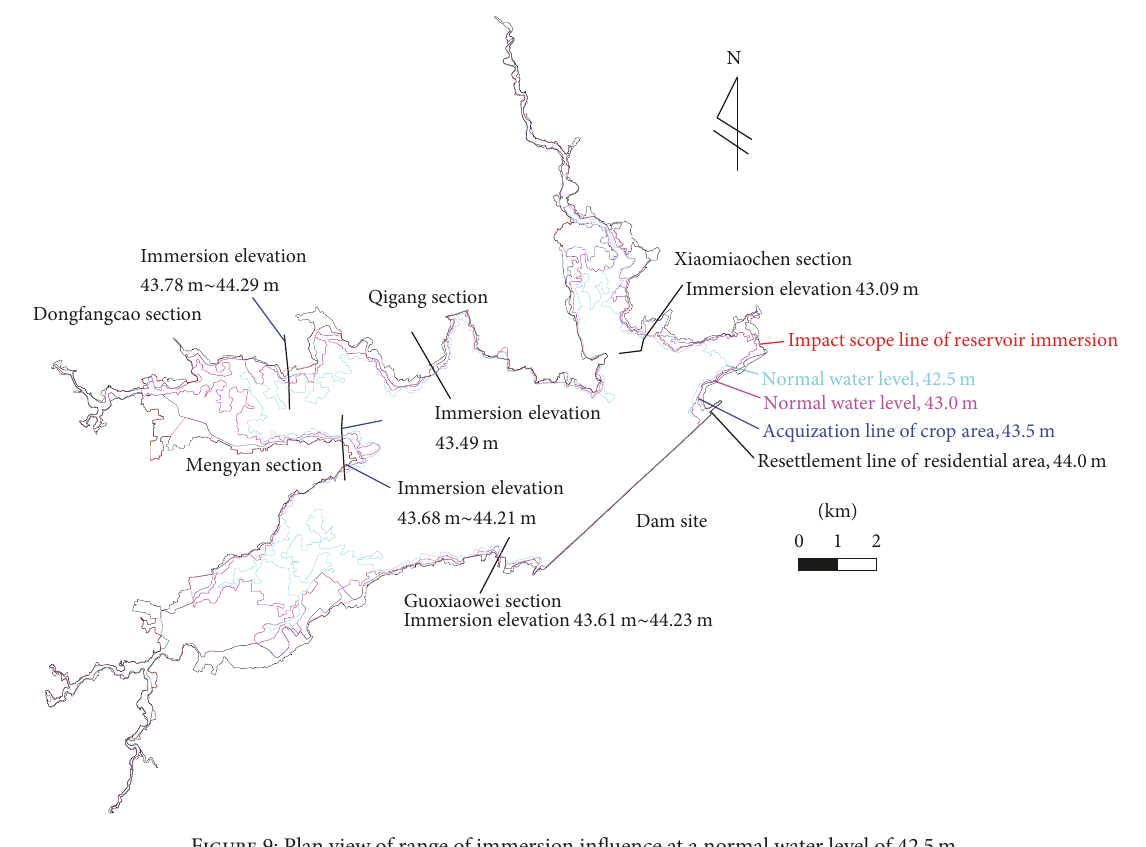
Figure 9: Plan view of range of immersion influence at a normal water level of 42.5 m.